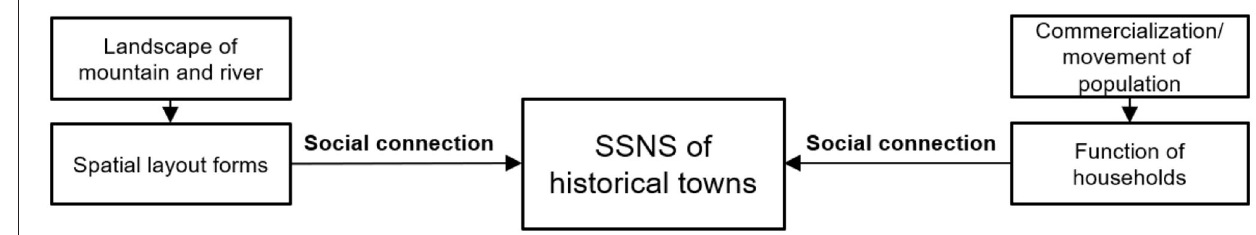
FIGURE 4 | Influencing factors for the SSNS of historical towns.